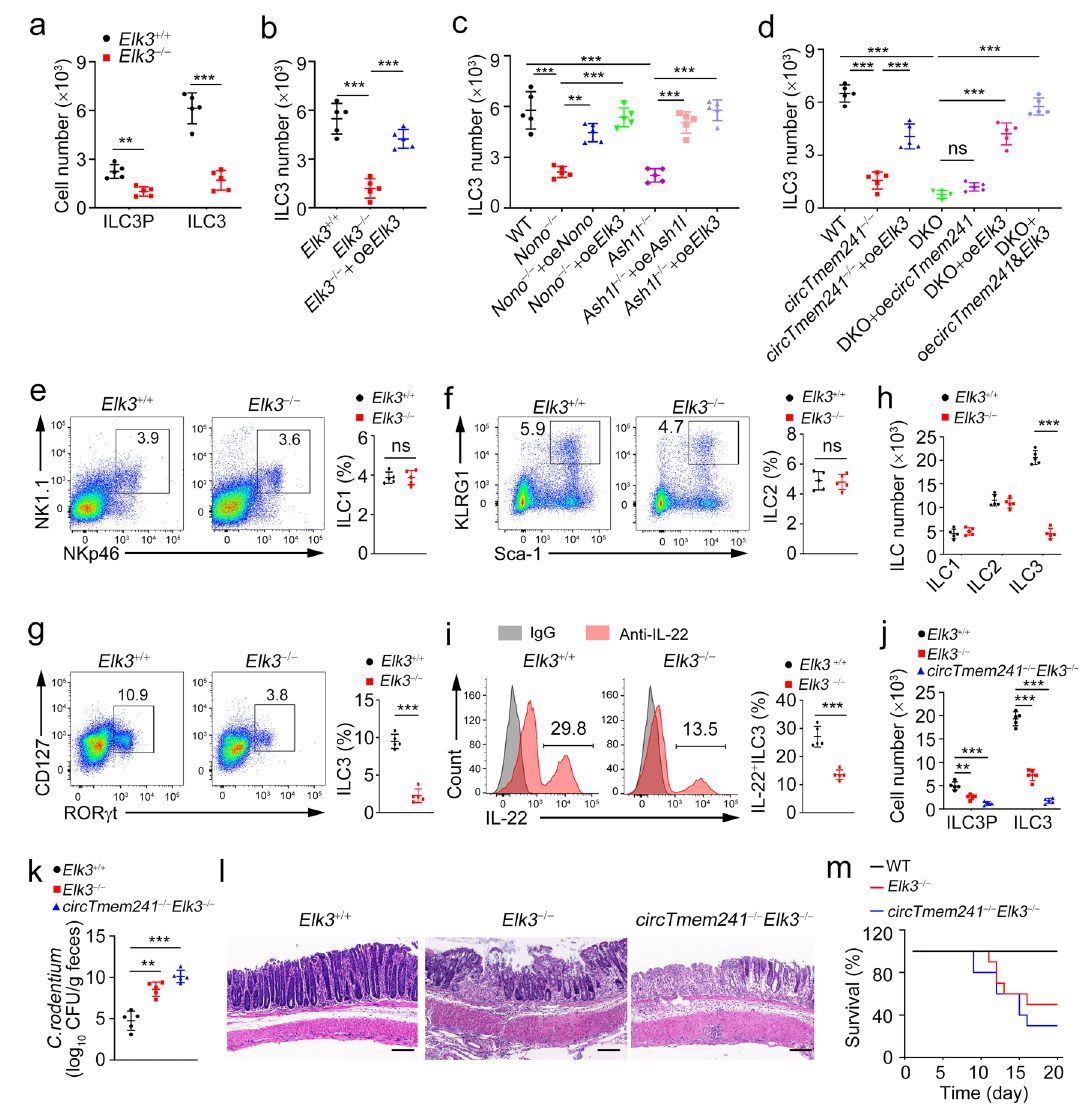
Fig. 7 | Elk3 knockout impairs ILC3 commitment and anti-bacterial immunity. a – d IndicatedILCPswereisolatedandconductedinvitrodifferentiationassaywith OP9-DL1 feeder cells. ILC3Ps were analyzed 7 days later and ILC3s were analyzed 14 days later by FACS. n =5 for each group. e – g ILC1s (CD3 − CD19 − CD45 + CD127 + gated),ILC2s (CD3 − CD19 − CD127 + CD90 + gated)and ILC3s (CD3 − CD19 − CD45 lo gated) were analyzed in small intestines of Elk3 +/+ and Elk3 − / − mice by FACS. n =5 for each group. h Numbers of indicated ILCs in e – g were calculated. n =5 for each group. i LPLs from Elk3 +/+ and Elk3 − / − mouse intestines were stimulated by IL-23 for 4h, followedbyIL-22 + ILC3detectionwithFACS. j ILC3PsandILC3sfrom Elk3 +/+ , Elk3 − / −